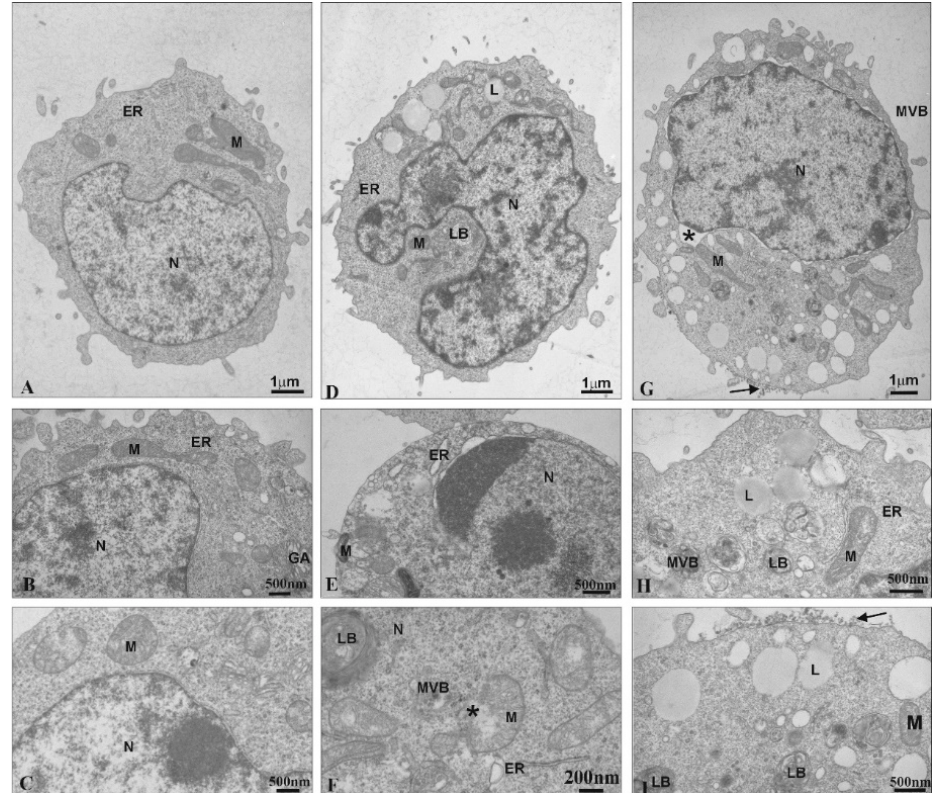
Figure 3. Ultrastructural changes in 1301 cells ( A – C ). Cells influenced by CRD13 at 2.5 µ mol / L ( D – F ) or CRD27 at 5 µ mol / L ( G – I ). Abbreviations: N—nucleus. Nu—nucleolus. M—mitochondria. MVB—multi-vesicular bodies. LB—lamellar bodies. L—lipids. GA—Golgi apparatus. ER—endoplasmic reticulum. *—vesicle containing CRD dendrimers.